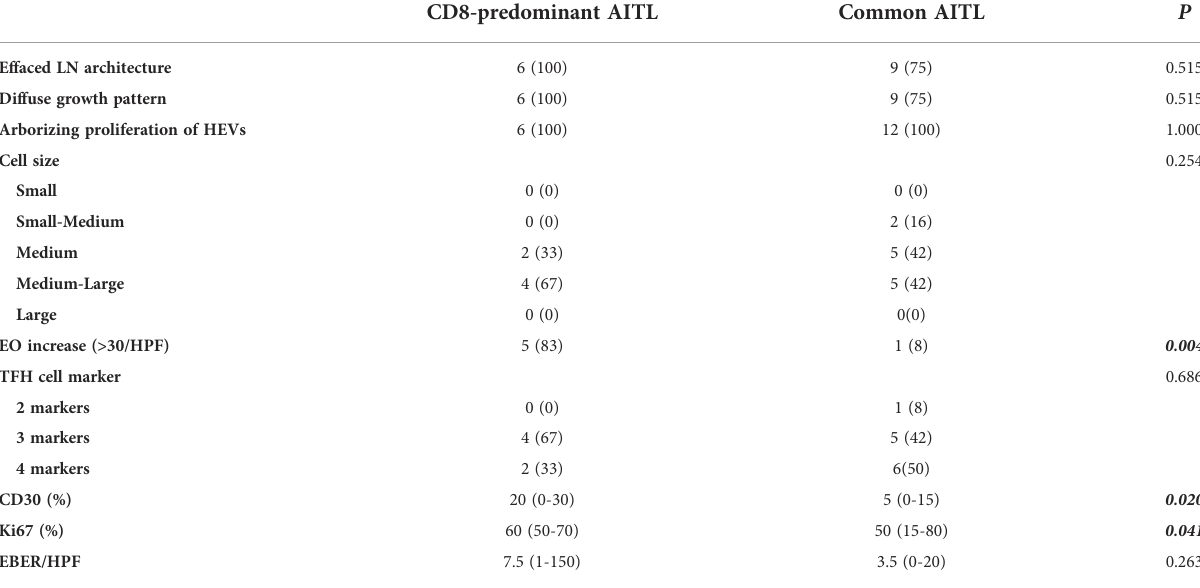
TABLE 2 Pathological comparison between CD8-predominant AITLs and matched normal